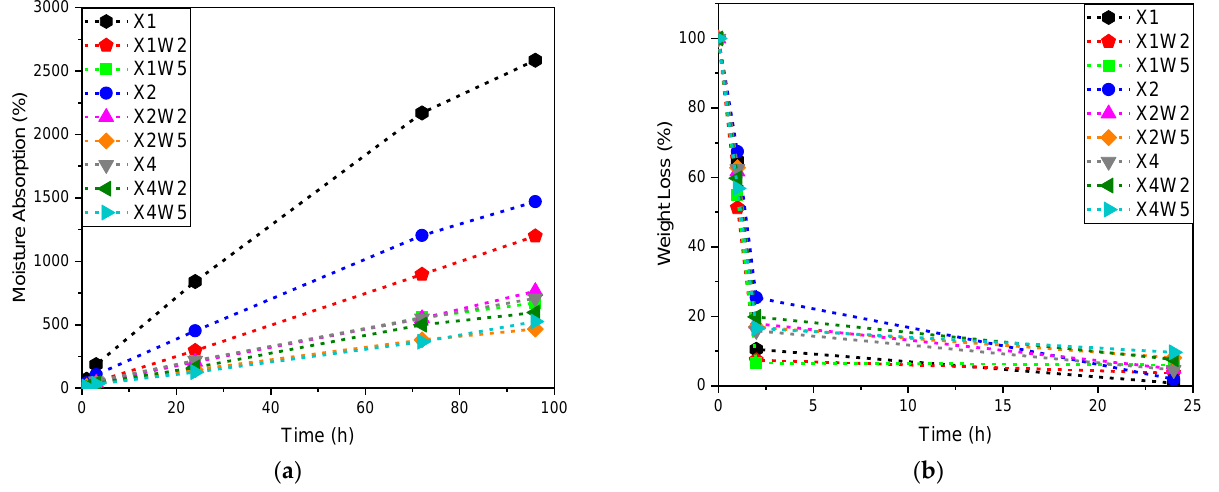
Figure 4. ( a ) Evaluation of the moisture absorption and ( b ) of the water release for the different hydrogel